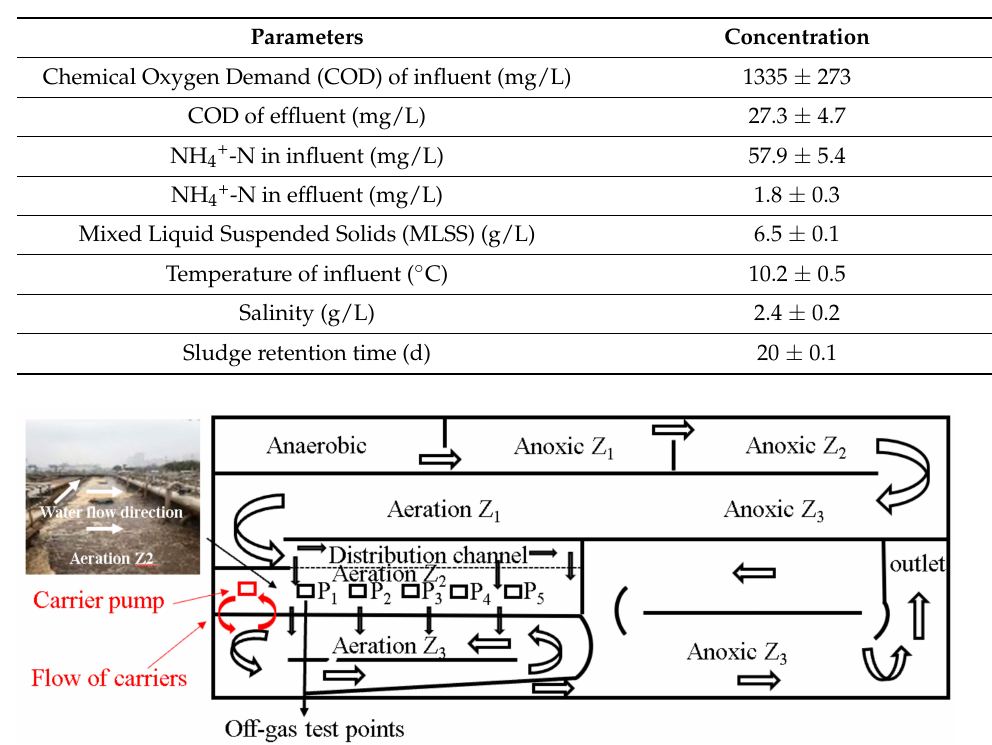
Figure 1. Tank geometry and off-gas test points.